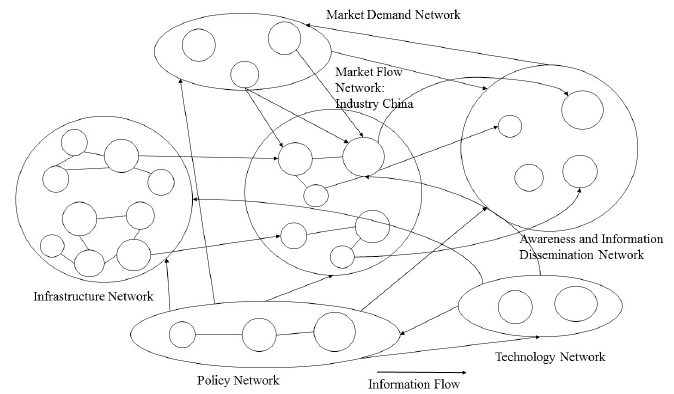
Figure 6. Social network analysis of bioenergy stakeholders [19].